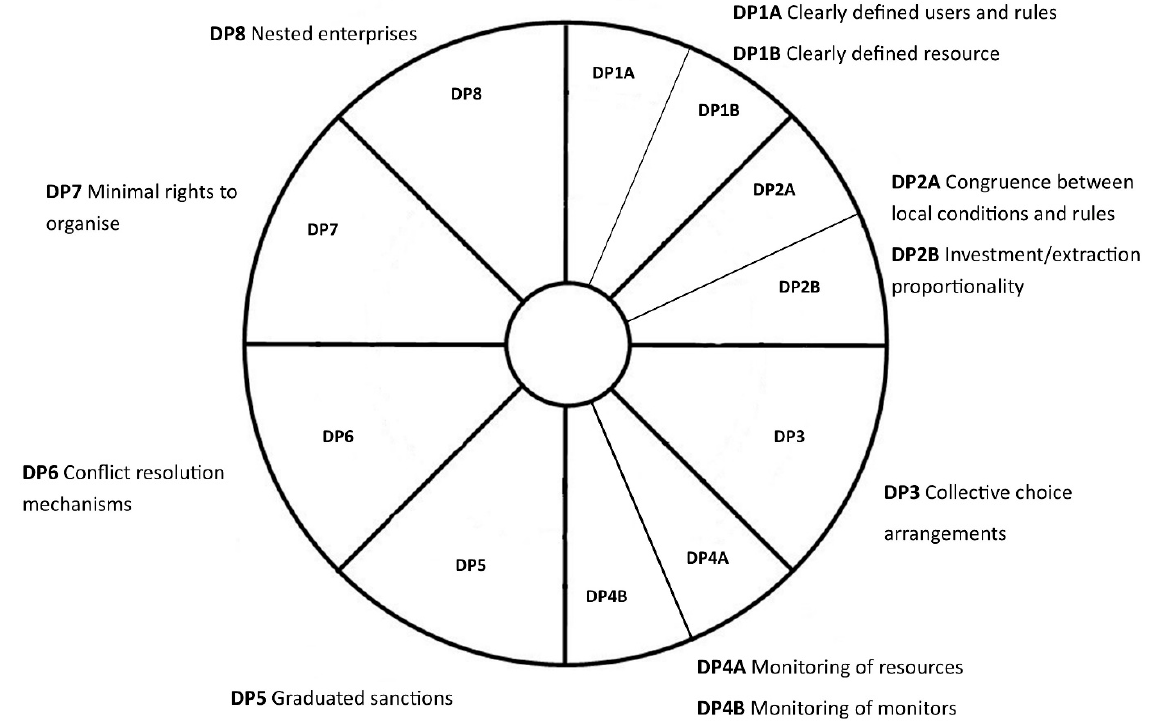
Figure 2. Primary chart for the CPR